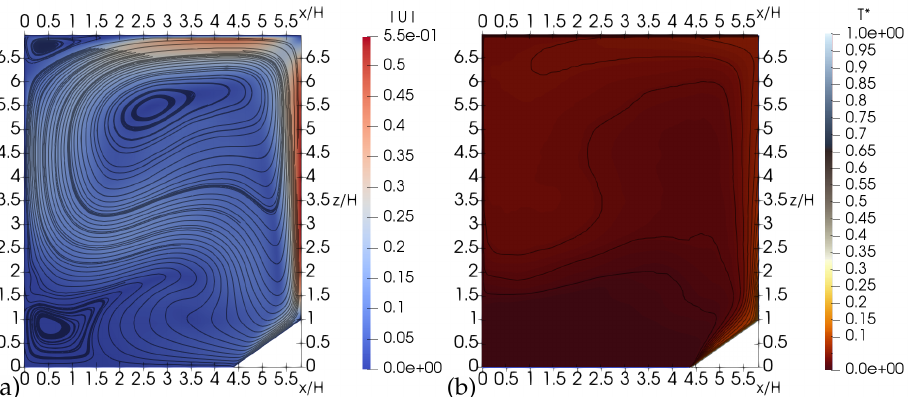
Figure 4. Distribution of velocity and temperature perturbation in the entire computational do- main: ( a ) non-dimensional average velocity magnitude | U | = |(cid:104) u (cid:105)| / U b and streamlines across the entire computational domain; ( b ) non-dimensional average temperature perturbation distribution T ∗ = (cid:104) T (cid:105) / T s and contour lines at 100 equally spaced values are reported as black solid lines. Par- ticularly, contour lines at levels T ∗ = 0.01,0.02,0.03,0.04 (from bottom to top) are clearly